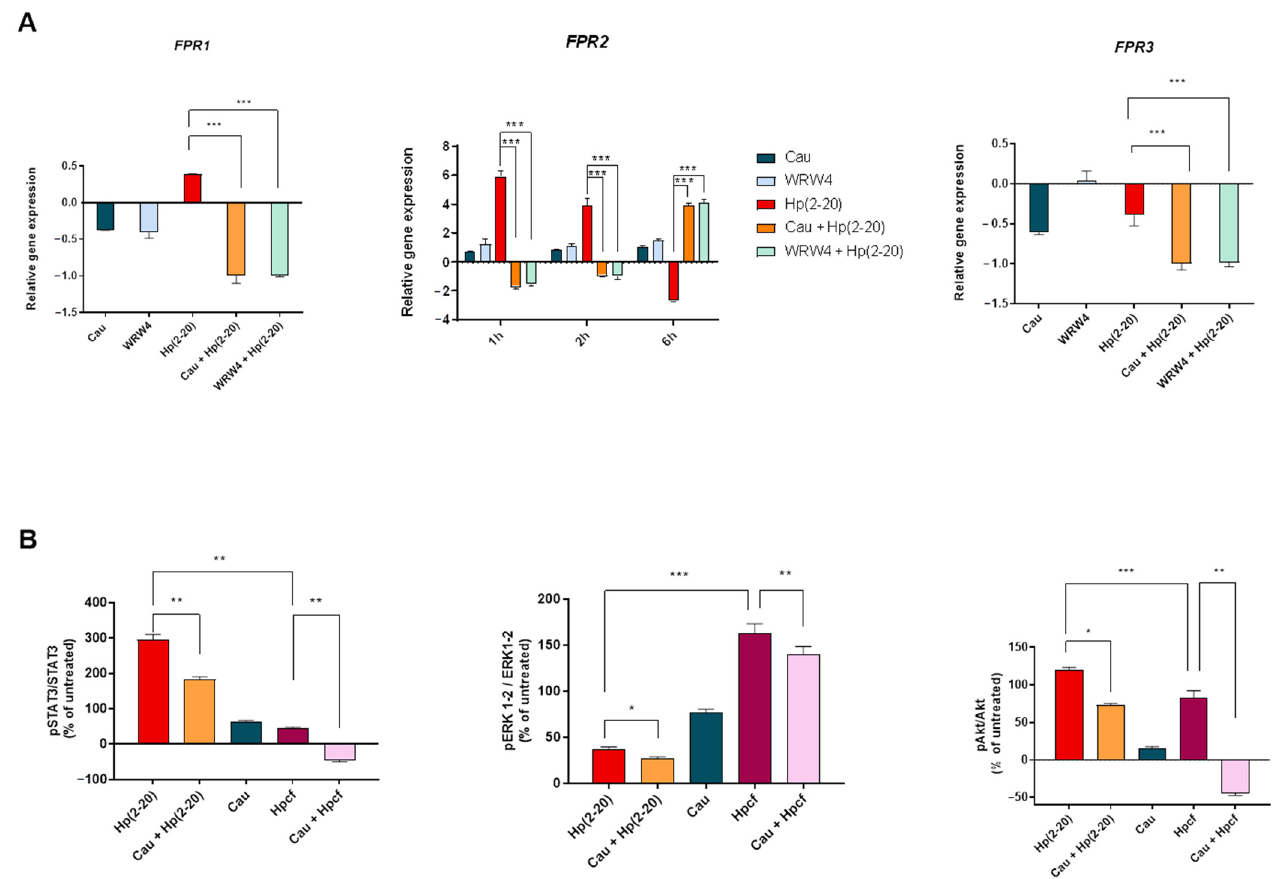
Figure 7. Cau inhibits FPR2 and its signaling cascade. ( A ) Relative gene expression of FPR1 , FPR2 and FPR3 by quantitative real time PCR (qPCR) in cells treated with: (1) Cau 15 µ M for 2.5 h; (2) WRW4 10 µ M for 2.25 h; (3) Hp(2–20) 25 µ M for 2 h; (4) Cau 15 µ M for 30 min and then Hp(2–20) 25 µ M for 2 h; (5) WRW4 10 µ M for 15 min and then Hp(2–20) 25 µ M for 2 h. FPR2 gene was further analyzed in cells treated as reported above, but incubated with Hp(2–20) for 1 or 6 h. All samples were normalized to GAPDH as reference housekeeping gene. Furthermore, relative gene expression was normalized to basal activity (untreated control), in order to obtain relative fold expression. ( B ) Densitometric analysis derived from Western Blot of the ratio pSTAT3/STAT3; pERK1-2/ERK1-2; pAkt/Akt, compared to control group. The analysis was performed on cell lysate prepared after stimulation with Hp(2–20) or Hpcf for 1 h; 15 or 5 min, respectively, either with or without Cau pretreatment (30 min). Vinculin was used for normalization. Graphs report the results of at least three independent experiments, represented as means ± SD. Statistical analysis was performed by GraphPad Prisma software, using one-way ANOVA followed by Bonferroni post hoc correction. * p < 0.05; ** p < 0.001; *** p < 0.0001.